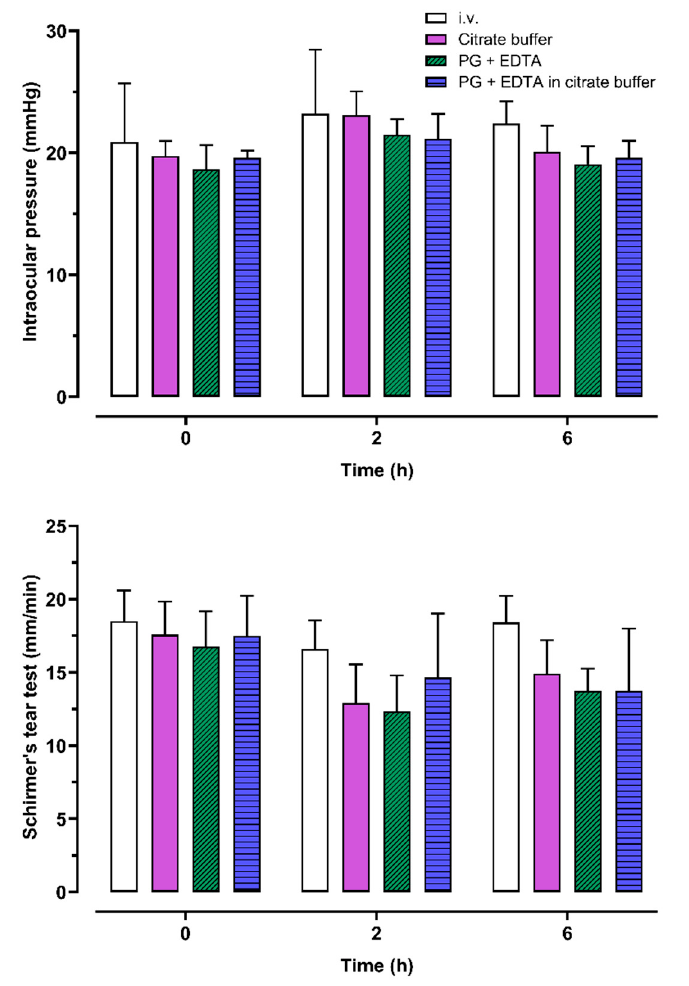
Figure 3. Intraocular pressure (upper panel) and tear production (lower panel) at baseline, 2 h, and 6 h, after either intravenous or ocular administration of 100 µg/kg naloxone to six male dogs. EDTA, ethylenediaminetetraacetic acid; i.v., intravenous; PG, propylene